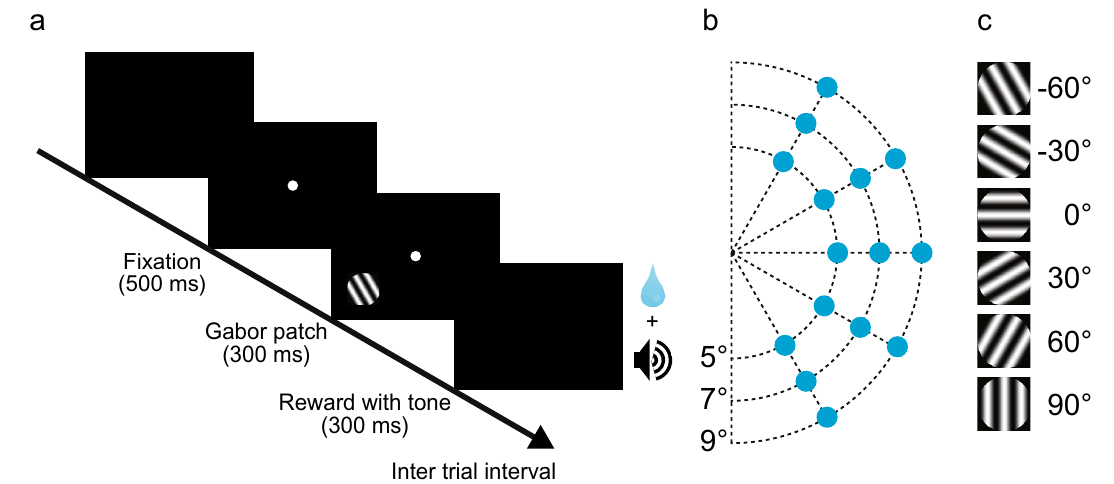
Figure 3. Fixation task with a Gabor patch presentation. ( a ) Time sequence of the fixation task with a peripheral Gabor patch presentation. After the monkey fixated on the central fixation point, a Gabor patch was briefly presented in its periphery. If the monkey kept fixated, a drop of water was given as a reward. ( b ) Blue circles indicate positions in the right visual field where the stimulus was presented in sessions to identify receptive fields for neurons recorded from the left hemisphere. ( c ) Six orientations of the Gabor patch presentation used in this